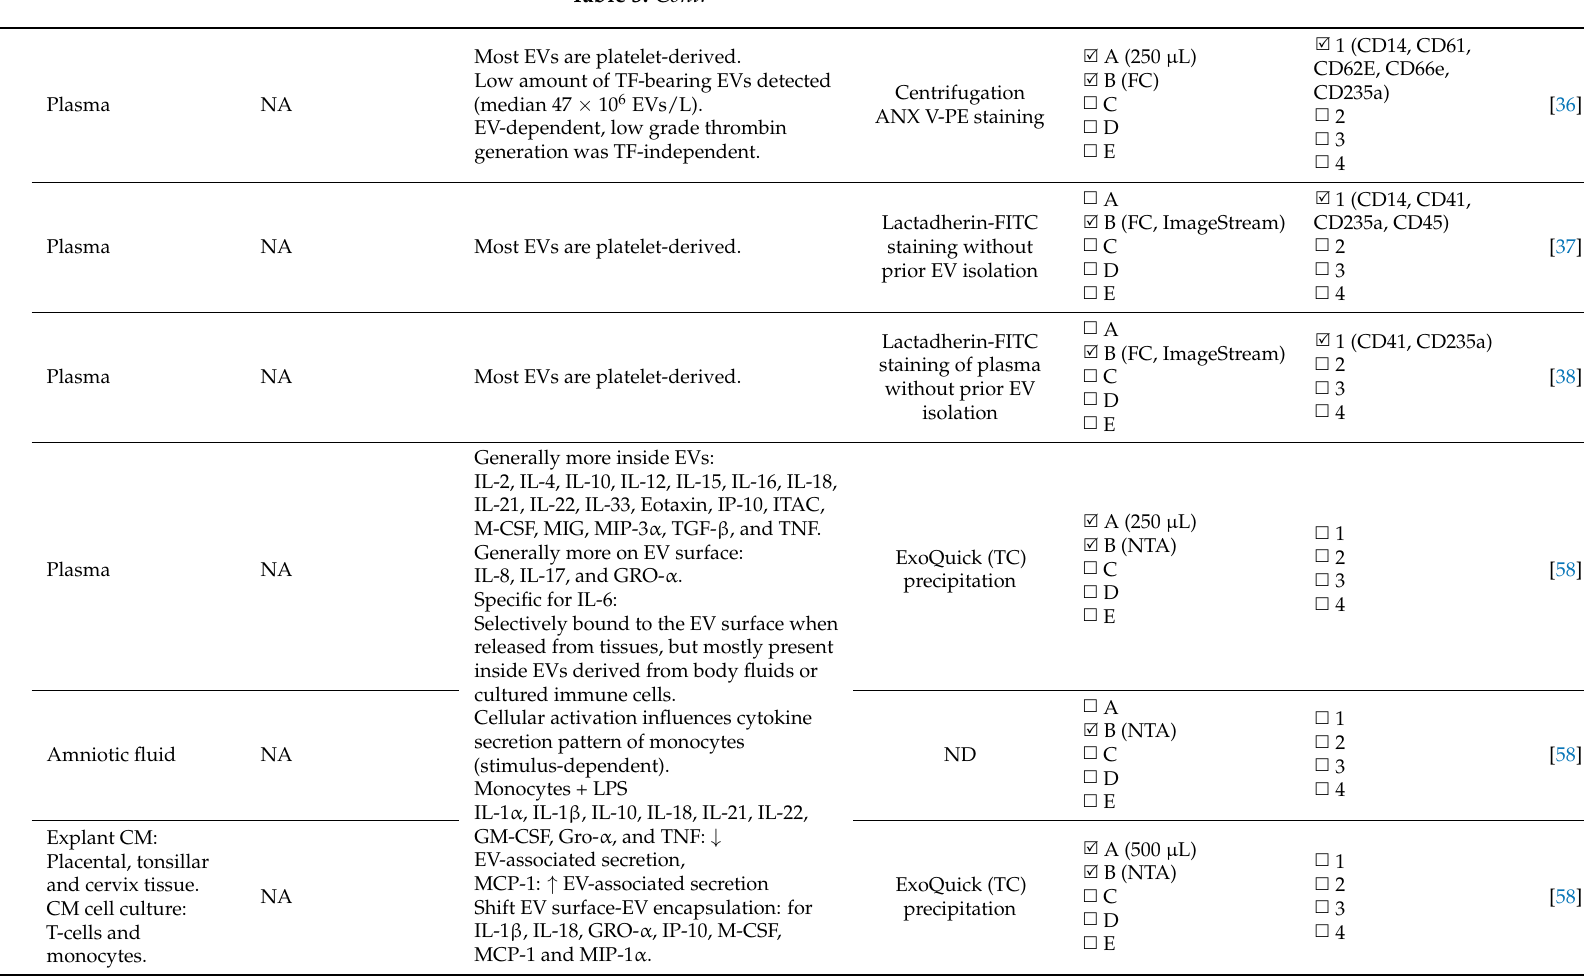
↑ PS-EVs Total EV amount in same range for DIC and non-DIC Combination of prothrombin time, EC-derived CD105+ patients. EVs and platelet count at D1 could predict DIC ab- Specific EV source pattern in DIC patients. sence. ↓ Platelet-derived EVs in DIC patients compared to ↑ PS-EVs non-DIC patients Combination of prothrombin time, EC-derived CD105+ Total EV amount in same range for DIC and non-DIC ↑ EC-EVs and leukocyte EVs in DIC (D1) EVs and platelet count at D1 could predict DIC ab- patients. ↑ Leukocyte- EVs in DIC at D7 Specific EV source pattern in DIC patients. ↓ Platelet-derived EVs in DIC patients compared to NA No difference in EV levels between sepsis/septic shock non-DIC patients patients and healthy donors. Serum NA ↑ EC-EVs and leukocyte EVs in DIC (D1) ↑ Leukocyte- EVs in DIC at D7 EVs injected (i.v.) in Swiss mice. EV levels: septic shock > sepsis without shock > healthy controls.